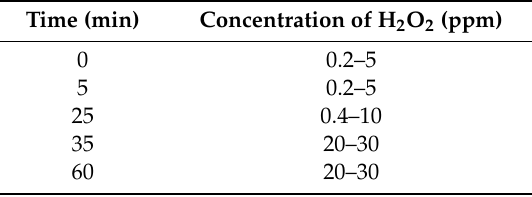
Table 1. Concentration of H 2 O 2 produced by aqueous suspensions of MgO 2 as analyzed by colorimetric Strips.